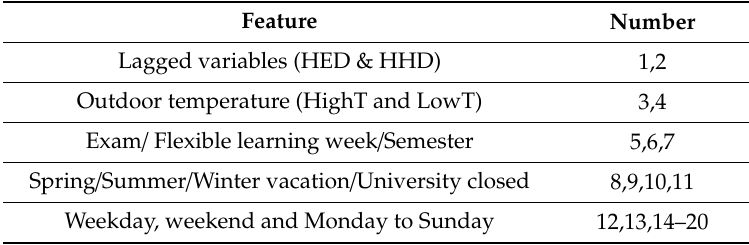
Figure 5. Evolution of performance of best feature set by iteration of Genetic Algorithms (GA) for electricity ( top ) and heat ( bottom ) for support vector regression (SVR) ( left ), Naive Bayes (NB) ( centre ), and K-Nearest Neighbours (KNN) ( right ) algorithms. Table 2. Full feature set and corresponding number.